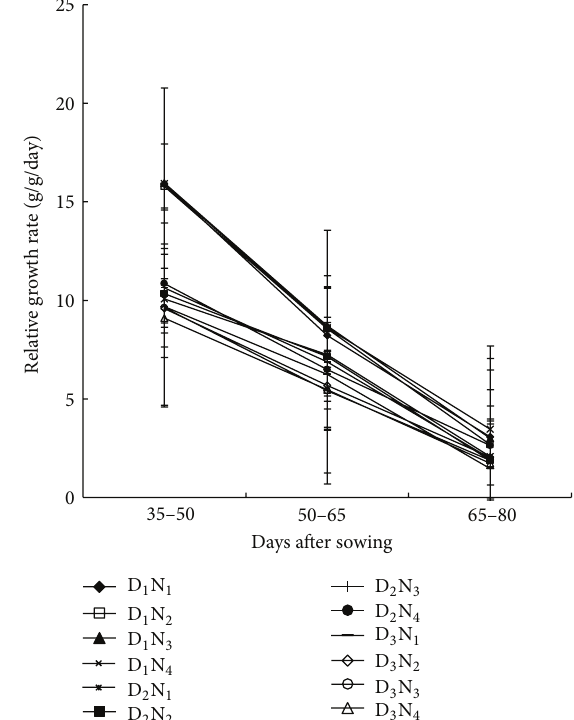
Figure 6: Relative growth rate of maize as affected by population density and N level at different growth period (D 1 = 53,000 plant/ha, D 2 = 66,000 plant/ha, D 3 = 80,000 plant/ha, N 1 = 100kg N/ha, N 2 = 140kg/ha, N 3 = 180 kgN/ha, N 4 = 220 kgN/ha. Bar showed ± SE